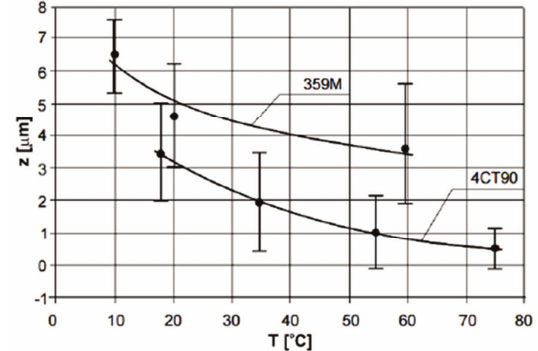
Fig. 4. The average cylinder wall wear (with standard error) for the diesel engine type 4CT90 and 359M dependence on temperature (T) after 1000 engine starts [4]